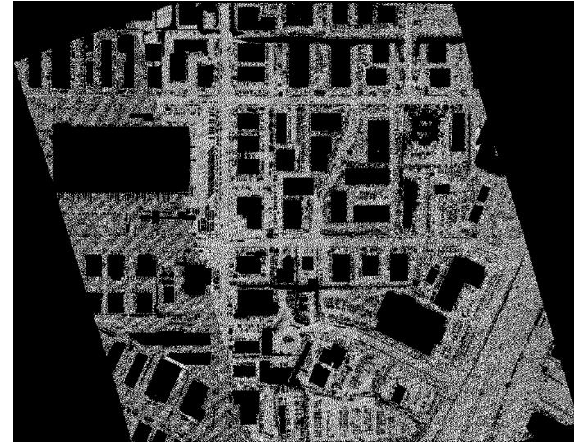
Figure 3. The extracted DTM points.